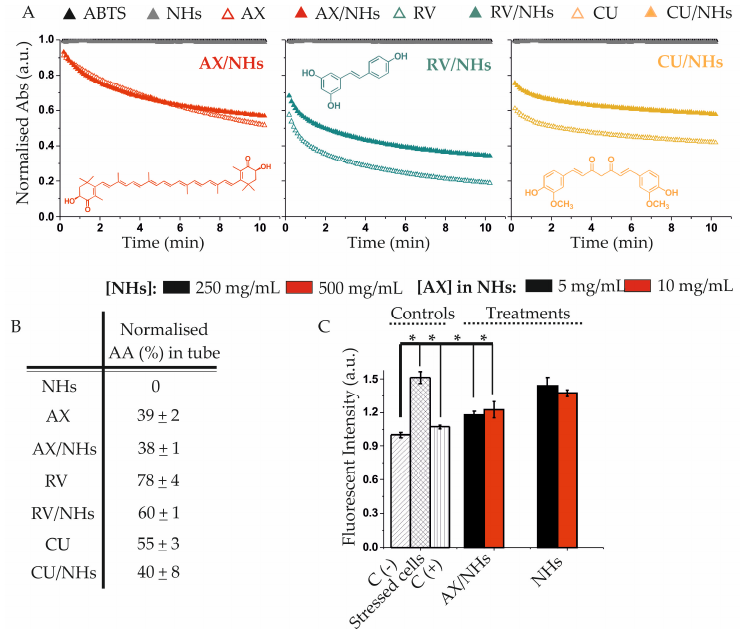
Figure 3. ( A ) Normalised Abs (λ = 730 nm) of AX/NHs, RV/NHs, CU/NHs and their controls versus 2,2′-azino-di-(3-ethylbenzthiazoline sulfonic acid) (ABTS). AX, RV and CU (loaded into NHs) were studied at the final concentration of 13 µM, respectively. Their absorbance (Abs) was compared to that of the free drugs at the same concentration. ( B ) Antioxidant activity (AA, %) of AX/NHs, RV/NHs, CU/NHs and their controls at 6 min. Data are expressed as the mean value ± standard deviation; experiments were performed in triplicate ( n = 3). ( C ) Cell antioxidant activity (CAA) of AX/NHs and free NHs in oxidatively stressed HUVECs at two different concentrations (corresponding to NHs concentration of 500 and 250 µg mL −1 and AX concentration of 5 µg mL −1 (8 µM) and 10 µg mL −1 (16 µM). Experiments were performed on 4 wells ( n = 3). Statistical significance was determined with Mann-Whitney test and asterisk denotes statistically significant differences (* p < 0.05).